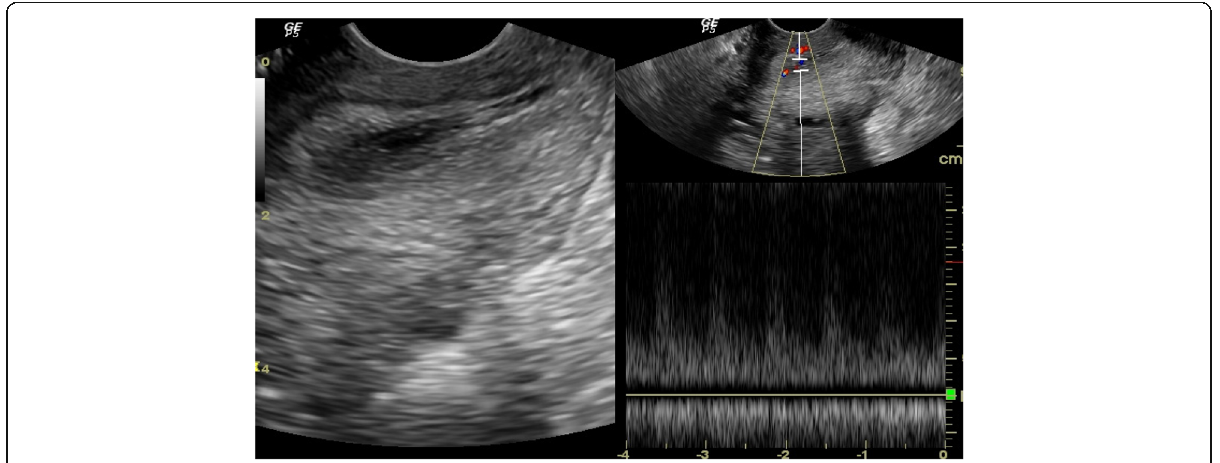
Fig. 2 Sagittal view by TVUS showing thickened echogenic endometrium and homogenous echo pattern measuring about 25 × 16 mm (CC X AP) with regular borders, preserving subendometrial halo and vascular pedicle. Histopathology analysis of the endometrial biopsy revealed endometrial polyp